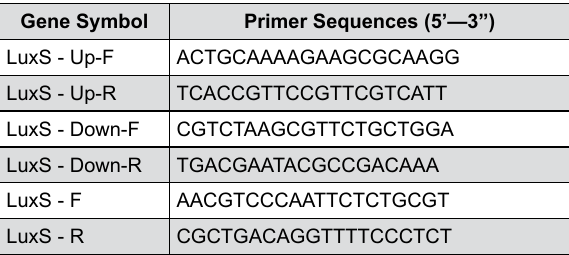
Figure 1- Primers sequences used in the real-time